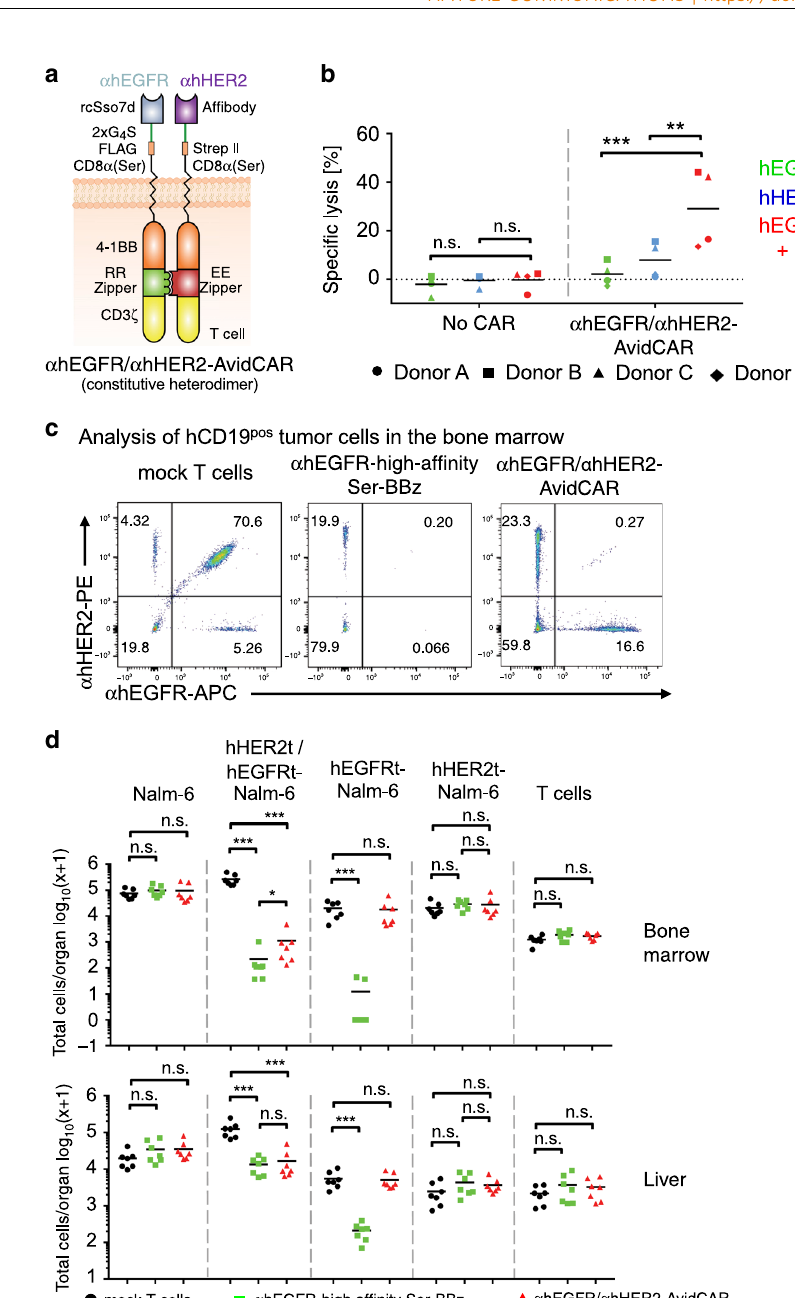
Fig. 6 Speci fi city of an AND-gate AvidCAR in vivo. a Schematic of a constitutively heterodimeric leucine zipper based AND-gate AvidCAR ( α hEGFR/ α hHER2-AvidCAR; SEQ-IDs 25 and 26). b Lysis of single- and double-antigen positive target cells by T cells expressing either no CAR or the α hEGFR/ α hHER2-AvidCAR ( fl ow cytometry-based assay; three independent experiments with four different donors; *** p < 0.001, ** p < 0.01, calculated by a mixed model, with CAR group, antigen, and their interaction as fi xed effects and the donor as a random effect to take into account the correlated structure, unadjusted two-sided p values are given). T cells were co-cultured with mRNA-electroporated Jurkat target cells expressing either hEGFRt or hHER2t or both antigens. c , d Speci fi city and ef fi cacy of AND-gated AvidCAR-T cells in vivo. NSG mice were injected via tail vein with 0.5 × 10 6 cells of a 1:1:1:1 mixture of Nalm-6, hEGFRt-Nalm-6, hHER2t-Nalm-6, and hHER2t-hEGFRt-Nalm-6 cells (Supplementary Fig. 9a) and 3 days later with 10 × 10 6 CAR-T cells or mock-T cells, as indicated. As a positive control we used the high-af fi nity α hEGFR-CAR, i.e., the Ser-BBz backbone (with integrated FKBP12-F36V domain) fused to the high-af fi nity EGFR-binder, from which the low-af fi nity version for the AvidCAR was derived. Mice were sacri fi ced 13 days after tumor injection. Bone marrow and liver was analyzed for tumor cell in fi ltration. c Representative fl ow cytometric analysis of the ratio of the four different Nalm-6 cell populations in bone marrow. See Supplementary Fig. 10 for the fl ow cytometric analyses of the organs of all mice and Supplementary Fig. 9b for the used gating strategy. d Total number of Nalm-6 cells and T cells in the bone marrow and liver of NSG mice ( n = 7, every data point represents one animal; * p < 0.05, *** p < 0.001, calculated by a two-way ANOVA analysis of log-transformed values). Exact p values are given in Supplementary Data 2. Source data are provided as a Source data fi